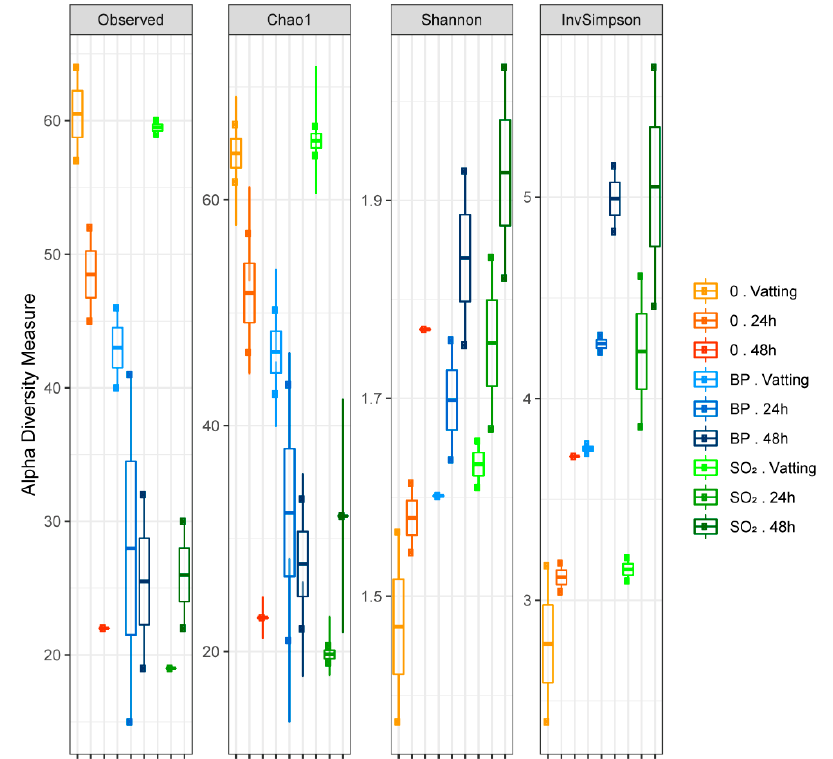
Figure 4. Boxplot of α diversity by four indices based on the taxonomic assignation of high-quality 18S rDNA reads of fungi from must samples at prefermentary stages (treatment: without SO 2 (0), SO 2 (SO 2 ), bioprotection (BP); stages: vatting, 24 h, and 48 h prefermentary maceration. Table 2. Percentage of variance explained by treatment and stage factors for different biodiversity indices (significance codes for p value: ** 0.01 and * 0.05).